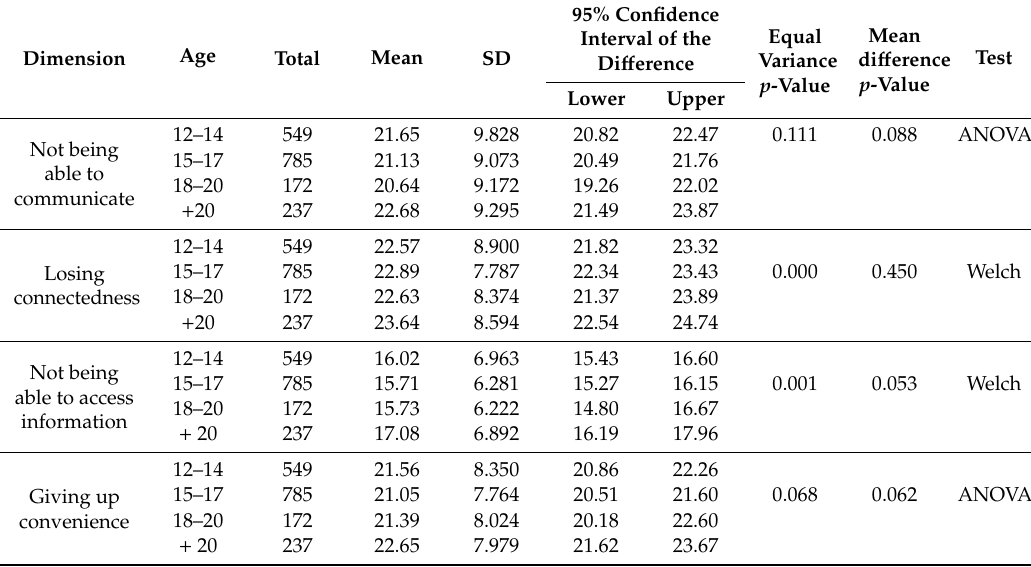
Table 3. Summary of means, SD, confidence interval, variance homogeneity, and ANOVA test of the dimension according to